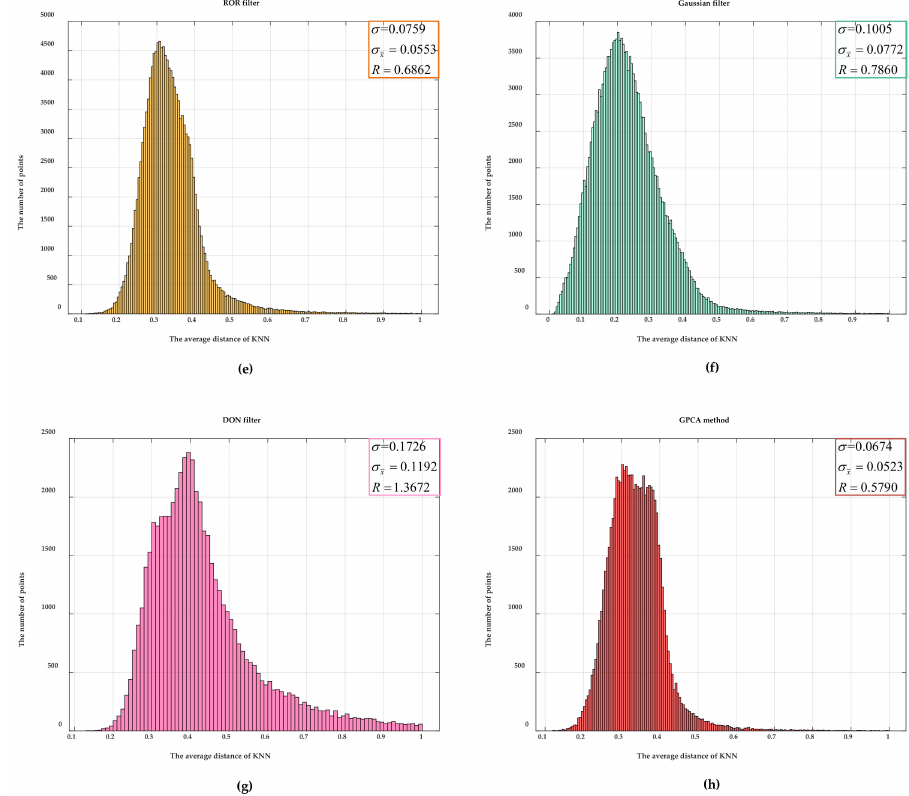
Figure 10. A statistical graph of the average distance of KNN: this average distance is used to evaluate the degree of data dispersion. We calculated three evaluation parameters for the initial and several filtered data. The standard deviation is expressed as σ . The mean variation is expressed as σ x . The range is expressed as R . ( a ) A statistical graph of the raw data, ( b ) a statistical graph of the data filtered by the artificial filter, ( c ) a statistical graph of the data filtered by the SOR filter, ( d ) a statistical graph of the data filtered by the VGSOR filter, ( e ) a statistical graph of the data filtered by the ROR filter, ( f ) a statistical graph of the data filtered by the Gaussian filter, ( g ) a statistical graph of the data filtered by the DON filter, and ( h ) a statistical graph of the data filtered by the GPCA method are presented.